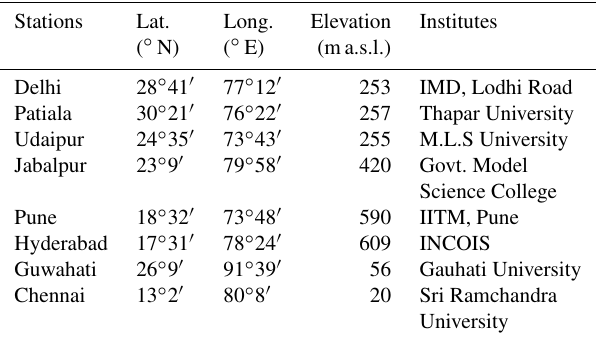
Table 1. Details of the locations of in situ ozone monitoring stations used in this study. All stations are categorised as semi-urban sites. All data were collected at an hourly resolution throughout the year 2013. For more details see Sect.